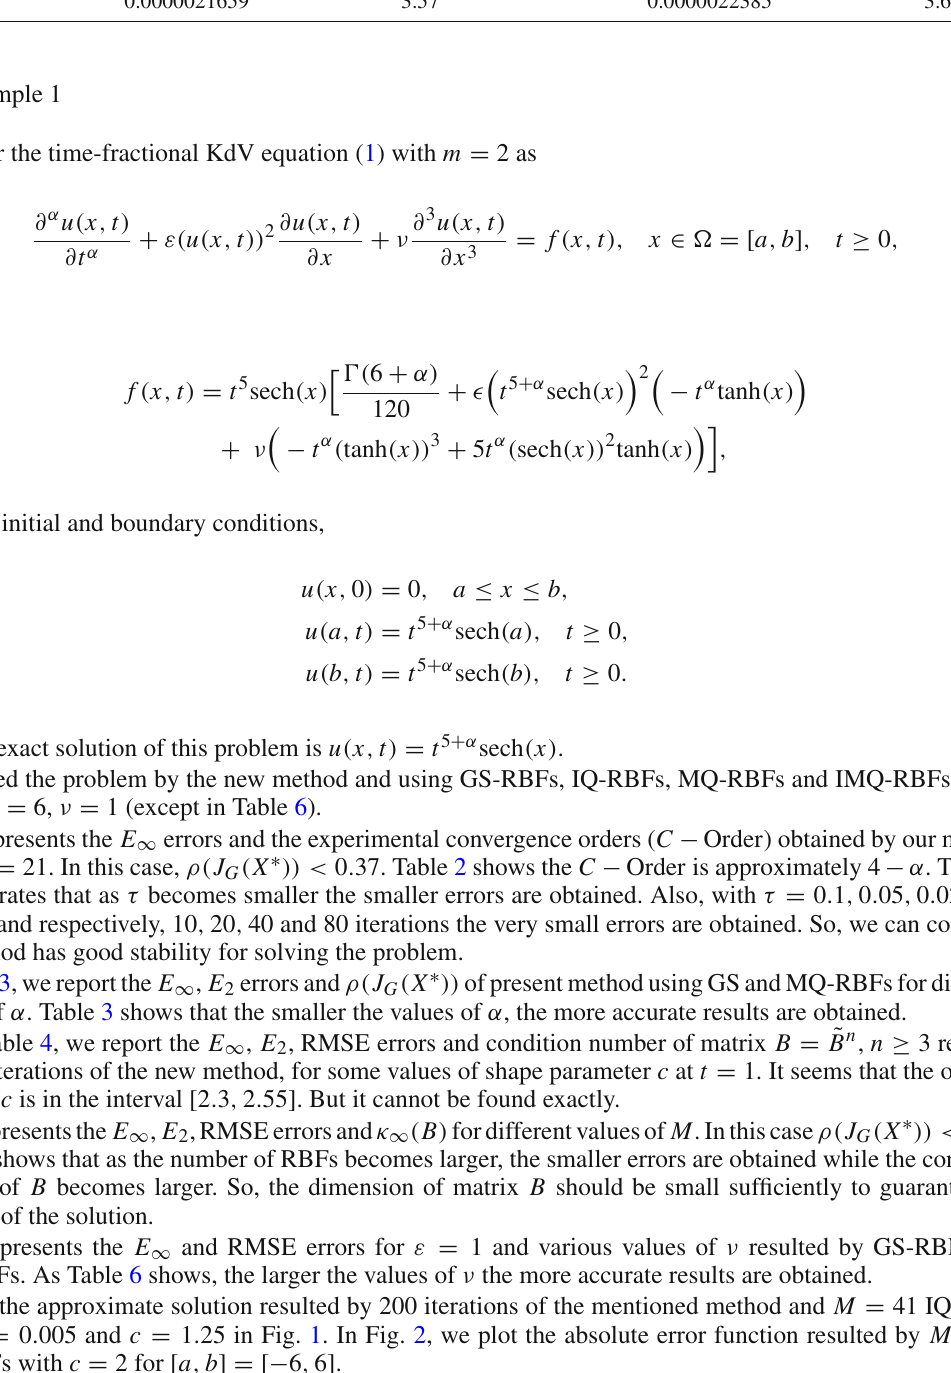
Table 2 The E ∞ error and C − Order for various values of τ resulted by IMQ-RBFs and IQ-RBFs with (cid:16) x = 0 . 05 and α = 0 . 4 for [ a , b ] = [− 2 , 2 ] and t = 1 in Example 1 τ IMQ ( c = 0 . 65 ) IQ ( c = 0 . 85 ) E ∞ C − Order E ∞ C − Order